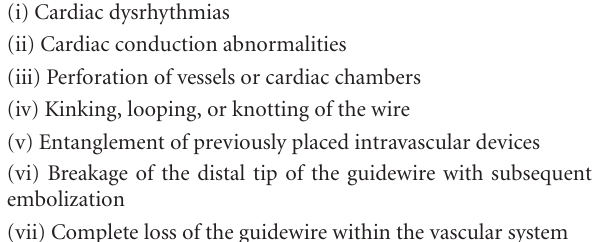
Table 1: The most commonly reported guidewire-related compli-